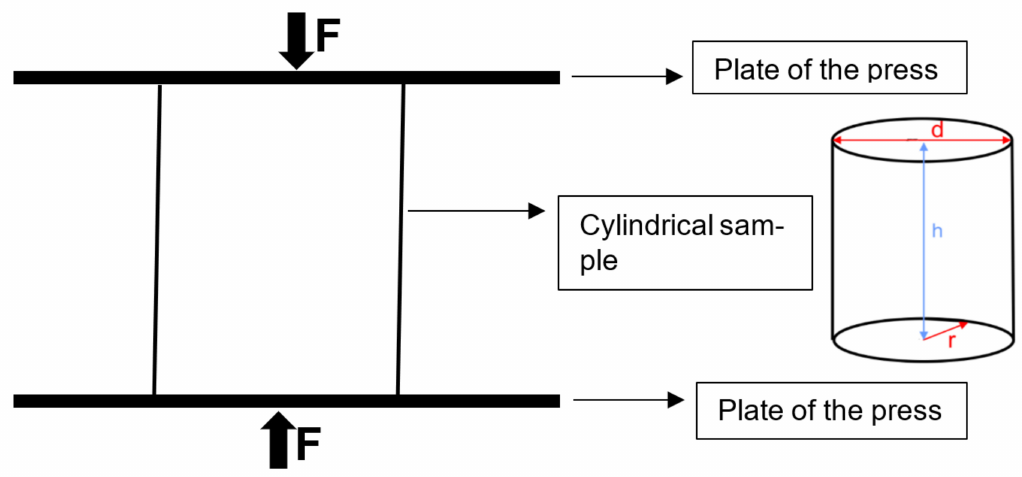
Figure 2. Compressive strength